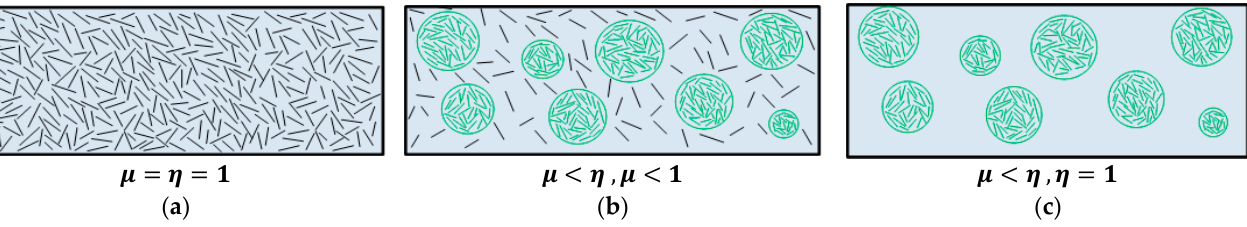
Figure 11. Agglomeration model of CNTs for the hybrid matrix: ( a ) partial agglomeration; ( b ) null agglomeration; and ( c ) complete agglomeration.